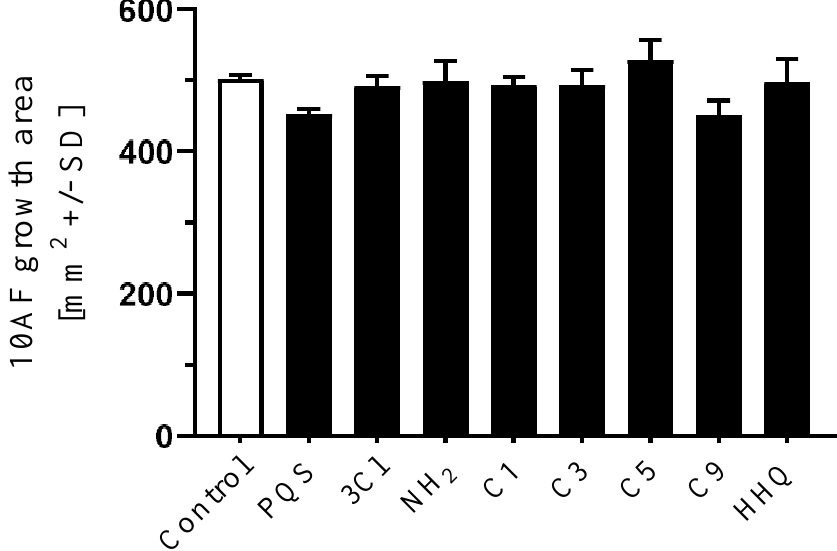
Figure 9. PQS and C9-PQS inhibit 10AF growth on agar. Effects of PQS, 3Cl-PQS (3Cl), NH 2 -PQS (NH 2 ), HHQ, and C1-, C3-, C5-, C9-PQS were tested against 10AF growth on RPMI agar. All molecules were tested at 12.5 µ g/mL. Only C9-PQS and PQS inhibited significantly (both p < 0.001), compared to control. PQS was more inhibitory compared to C1-PQS, C3-PQS, C5-PQS (all p < 0.001), and to NH 2 -PQS, 3Cl-PQS, HHQ (all p < 0.05). PQS and C9-PQS inhibited growth equally.